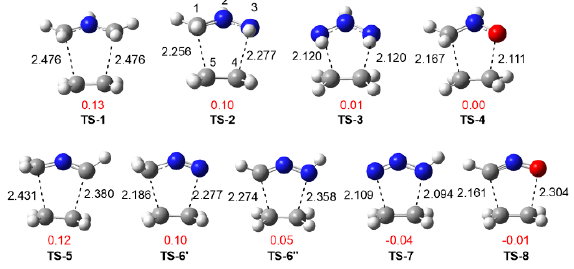
Figure 4. MPWB1K/6-311G(d,p) gas-phase optimized geometries of the TSs involved in the 32CA reactions of TACs 1–8 with ethylene 9 . Distances are given in angstroms, Å, while the GEDT values computed at the TAC framework, in red, are given in number of electrons, e.